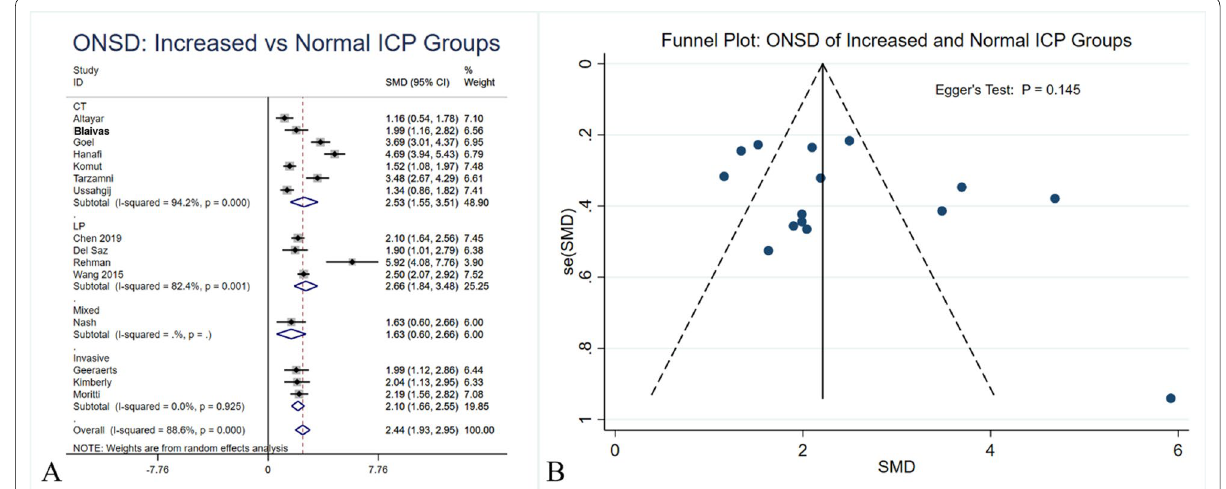
Fig. 2 Optic nerve sheath diameter (ONSD) measured by ultrasound (US) between patients with elevated intracranial pressure (ICP) and normal cohort ( A ). Funnel plot and Egger’s test evaluating publication bias ( B